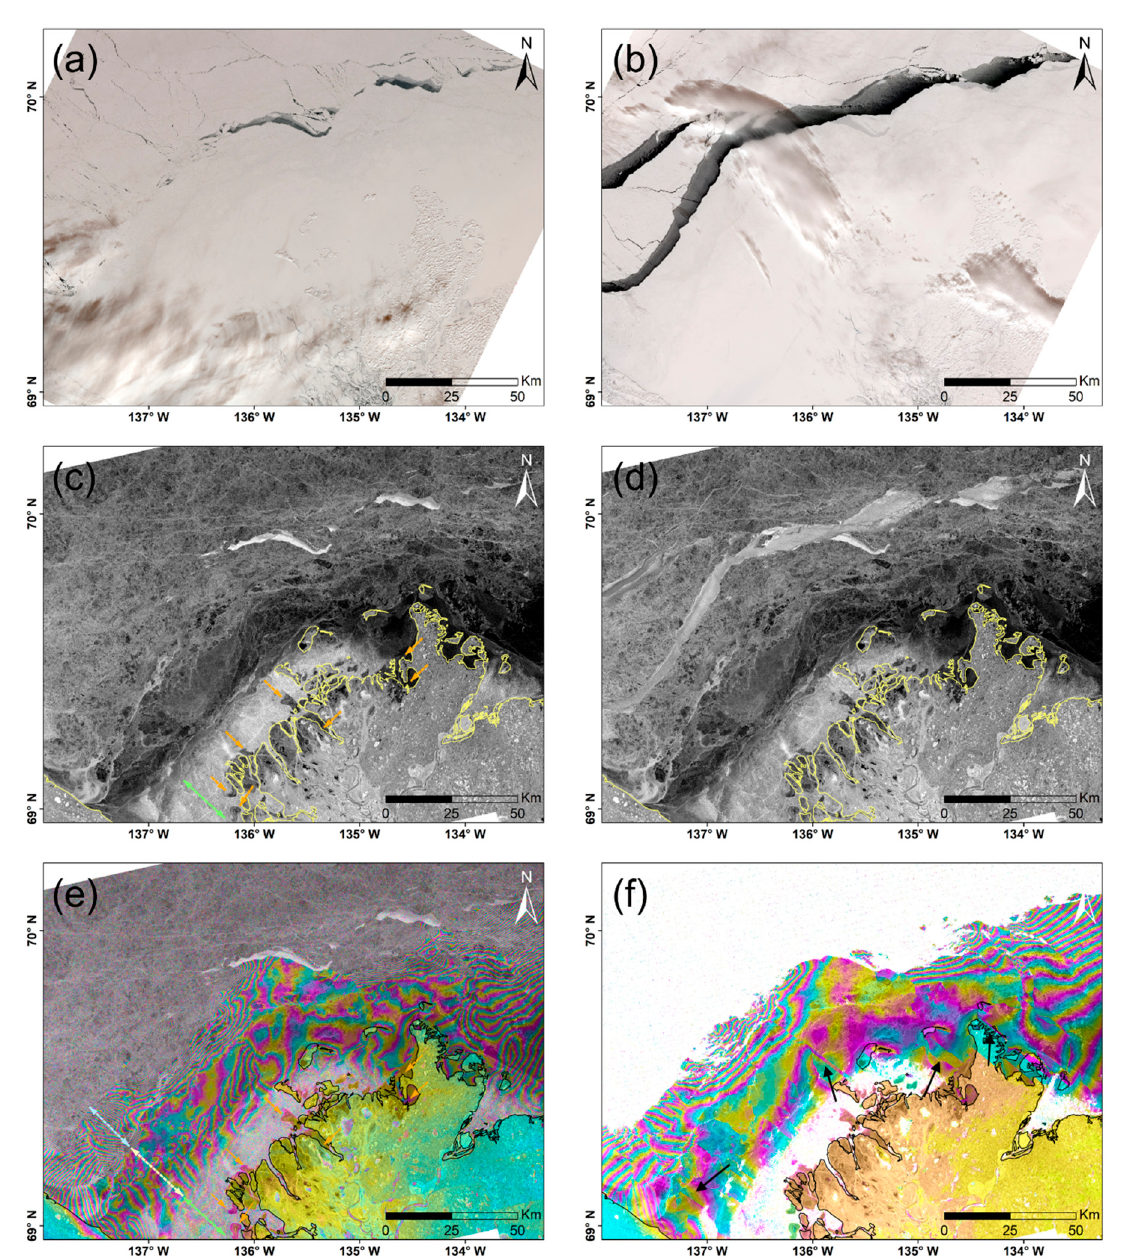
Figure 2. Landsat 8 and Sentinel-1 observations of landfast ice in the Mackenzie Delta. ( a ) Landsat 8 true color composite of 20170313 (yyyymmdd). ( b ) Landsat 8 true color composite of 20170329 showing open water leads after a breakup. ( c ) SAR intensity image of 20170319. ( d ) SAR intensity image of 20170331. ( e ) SAR interferogram of 20170319–20170331 overlaid on the intensity image of 20170319. ( f ) Unwrapped phase showing discontinuities (black arrows) of 20170319–20170331. The SAR intensity images were linearly stretched between − 25 and − 5 dB. The orange arrows represent bottomfast ice. The green, light yellow, and light blue dashed lines with double arrows represent the ranges of inner stabilized floating ice, outer stabilized floating ice, and non-stabilized floating saline ice, respectively. The coastline is shown in yellow ( c , d ) and black ( e , f ).